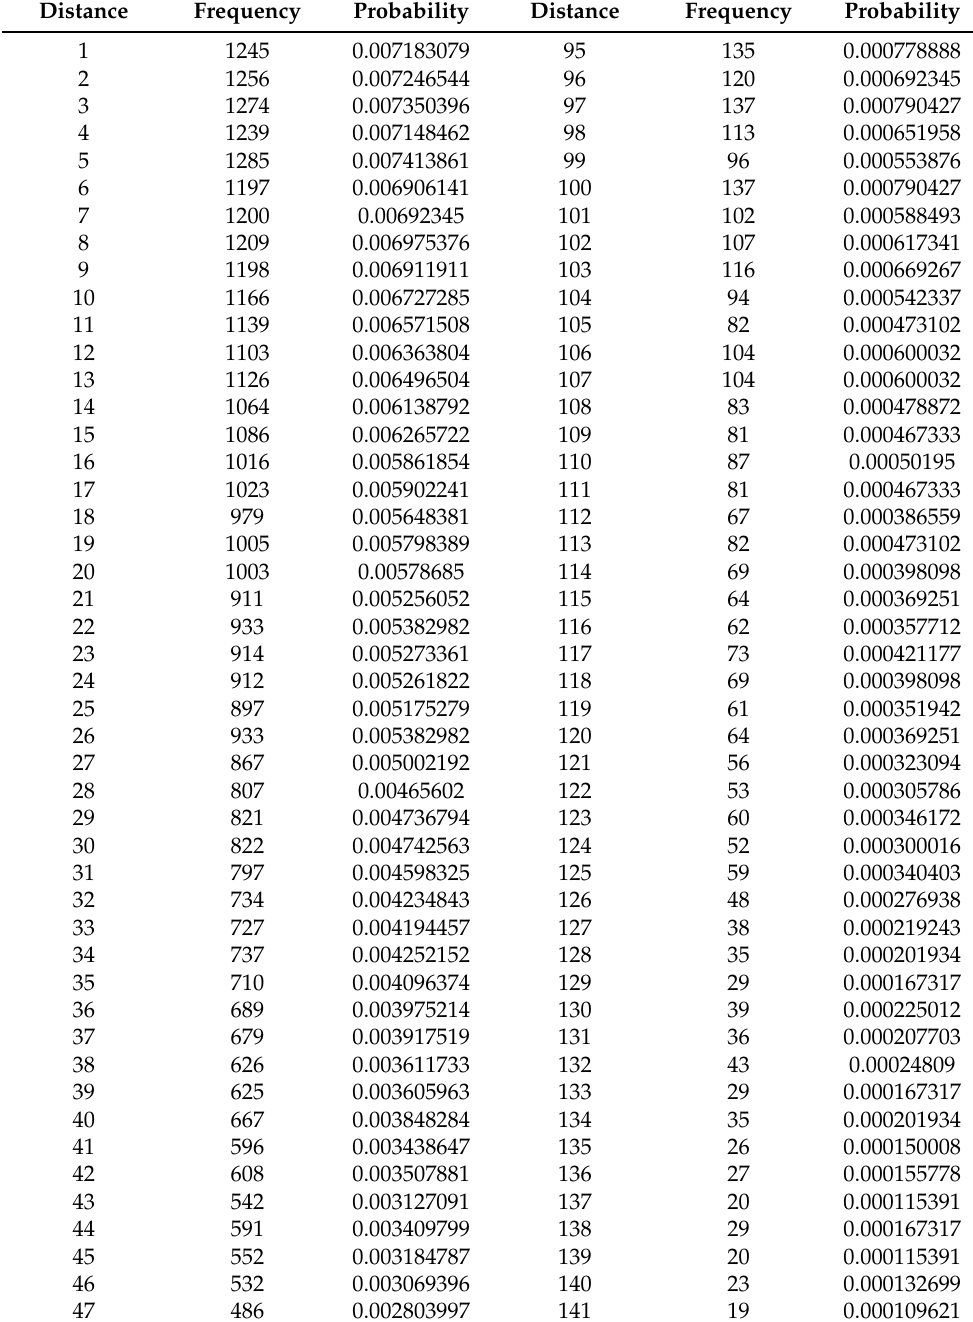
Table A2. Acquisition noise distribution table in grayscale